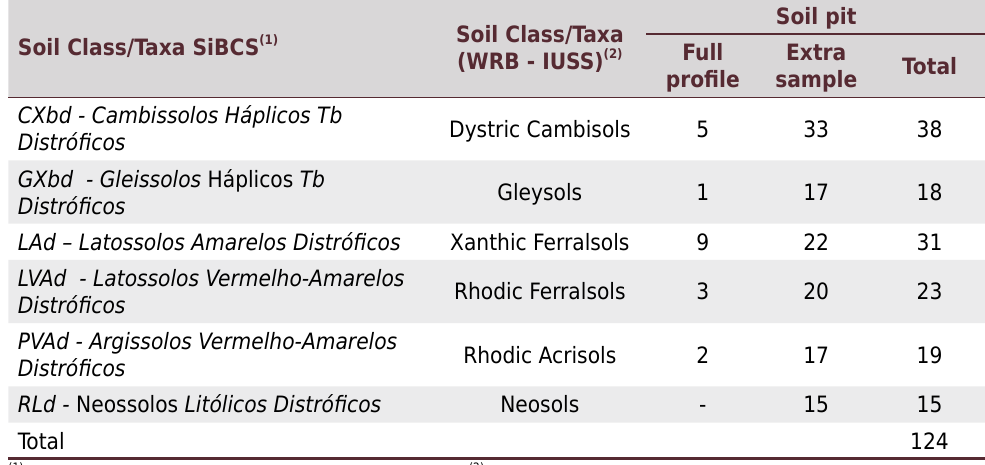
Table 1. Soil classes and number of soil pits surveyed per class in the Dênis Gonçalves settlement Soil Class/Taxa SiBCS